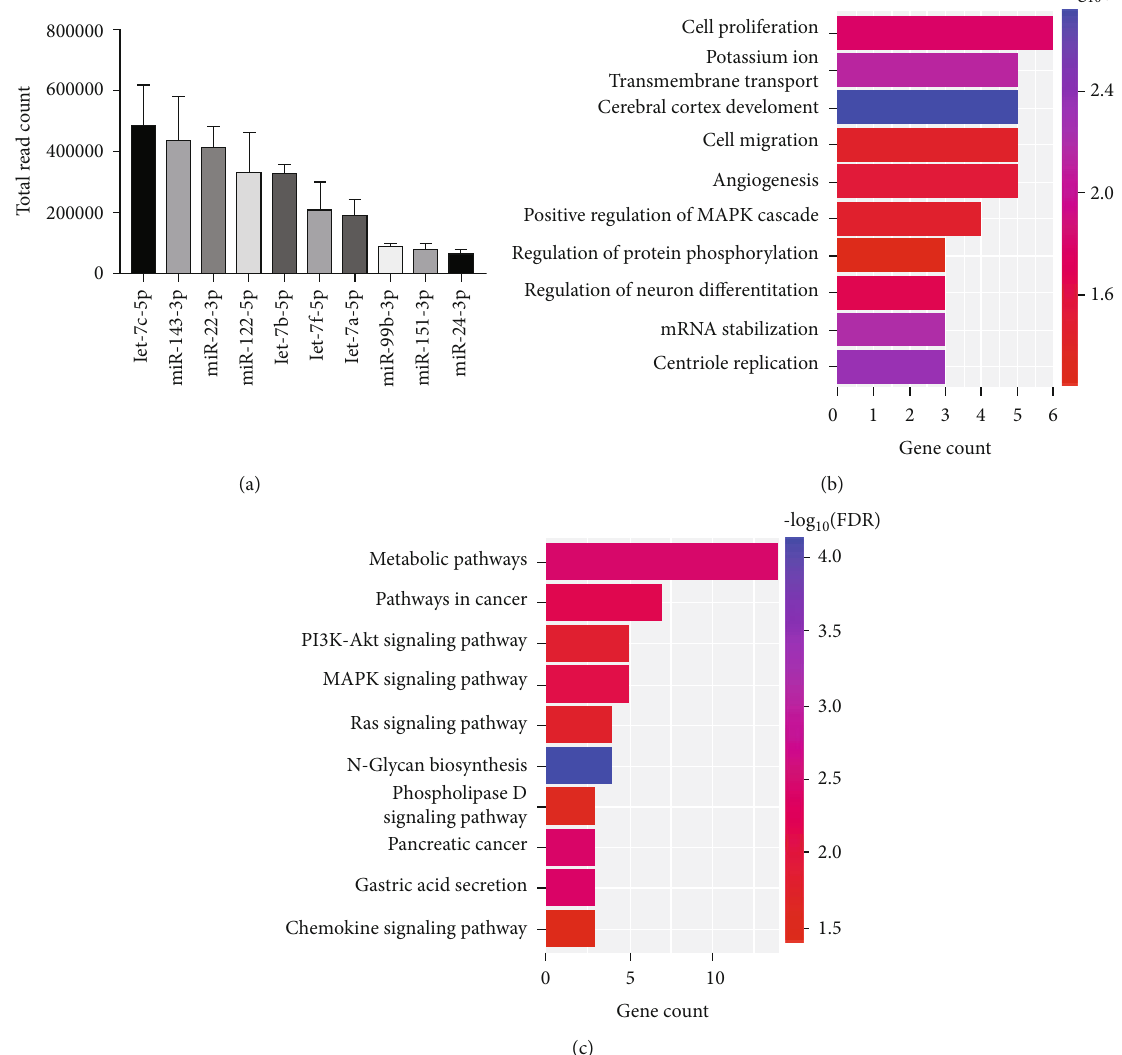
Figure 7: miRNA sequencing and bioinformatics analysis of ADSC-EVs. (a) The top 10 miRNAs that were detected in ADSC-EVs ( n = 3 ). (b, c) GO and KEGG pathway enrichment analyses of the possible target